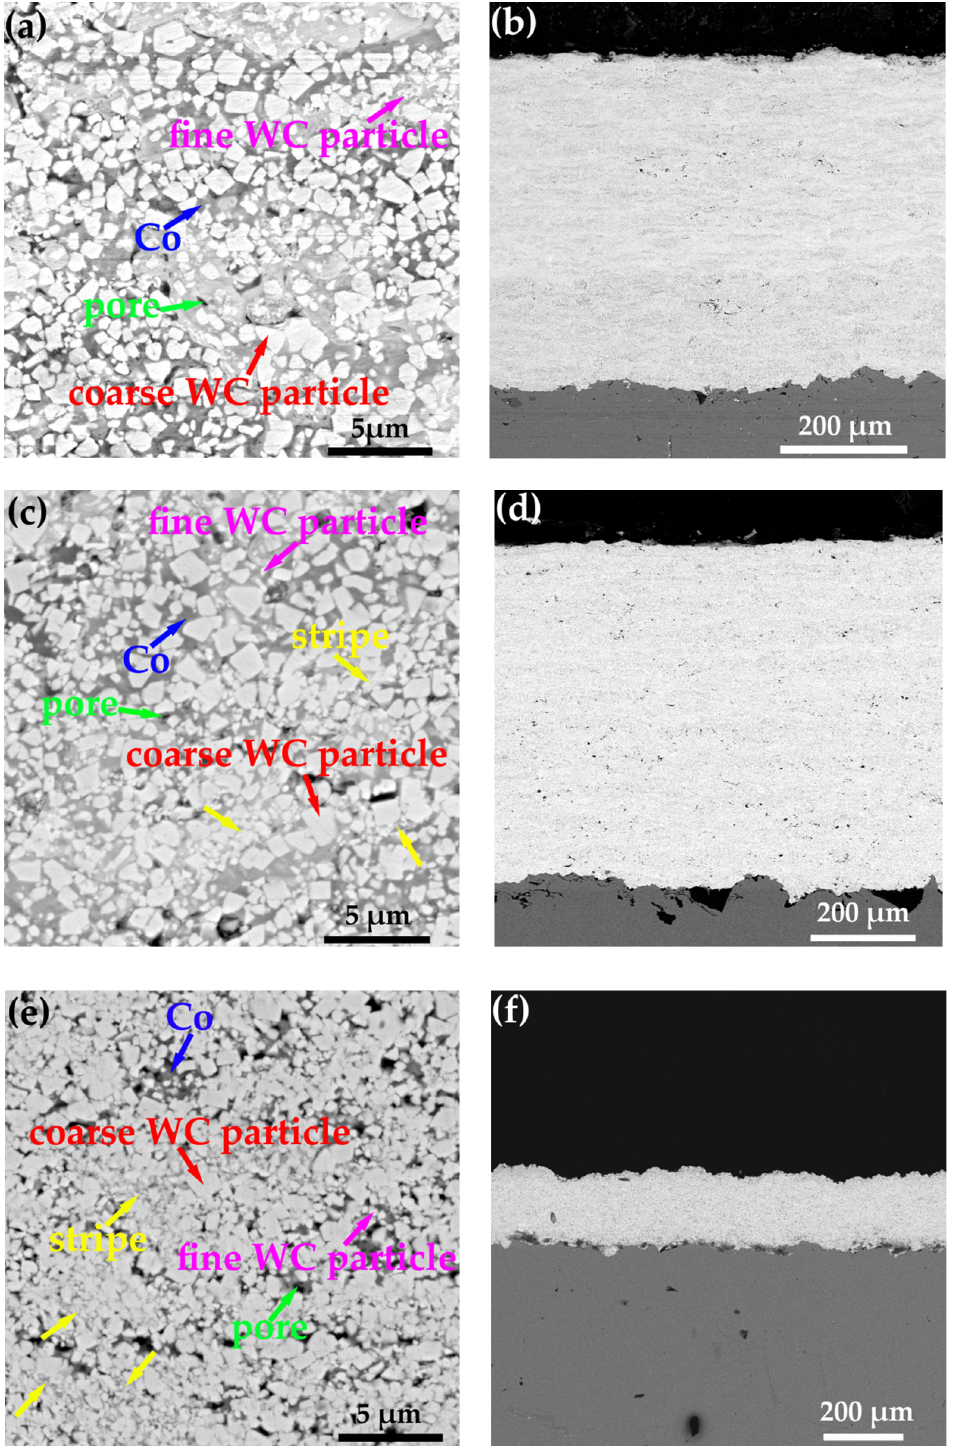
Figure 11. Cross-section morphologies of WC-17Co coatings formed by various spraying methods ( a , b ) HVOF , ( c , d ) WS, ( e , f )